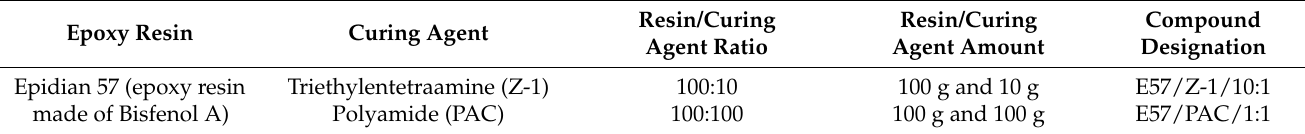
Table 1. Epoxy compounds and their